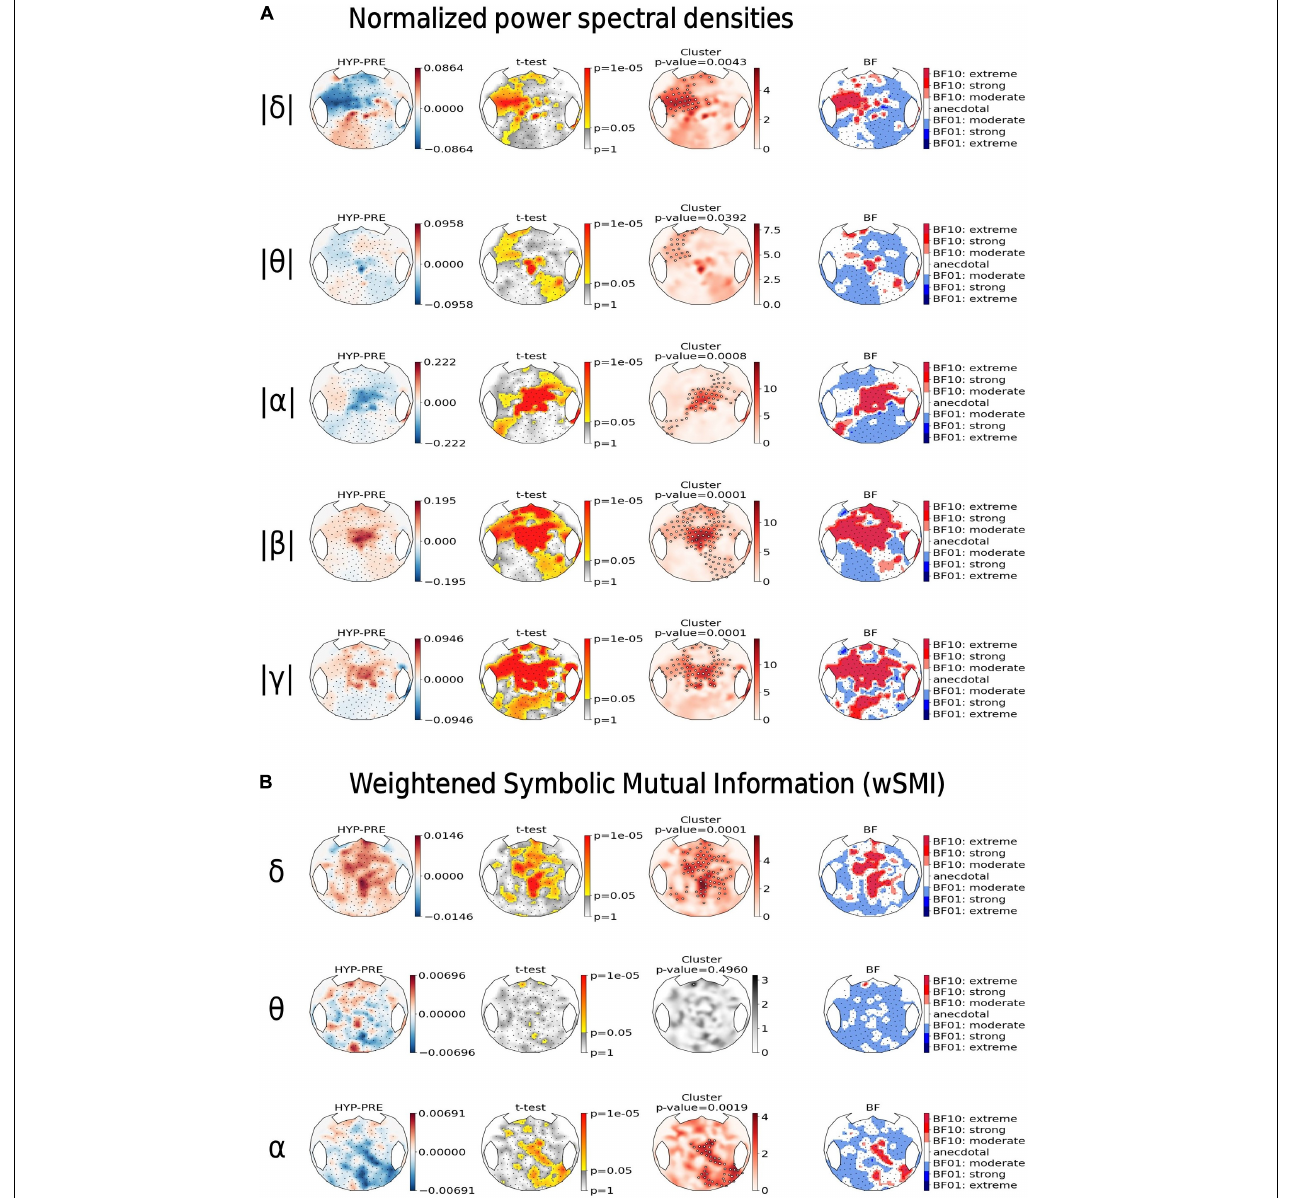
FIGURE 5 | Hypnotic deafness was associated with an increase in high-frequencies power and band-specific modulation of functional connectivity. Topographical maps of the normalized power spectral densities (PSD) (A) and the connectivity marker weighted symbolic mutual information (wSMI) (B) , computed at different frequency bands [delta ( δ ), theta ( θ ), alpha ( α ), beta ( β ), and gamma ( γ )]. For each state marker (row), from left to right: the first plot shows the contrast between baseline (PRE) and hypnotic deafness (HYP) states (HYP minus PRE), at each sensor; the second plot shows the result (uncorrected p -value in a logarithmic scale) of the independent t -test (HYP vs. PRE), at each sensor; the third plot shows the results of a cluster-based permutation test for control of multiple comparisons (red: significant cluster; gray: non-significant cluster); and the fourth plot shows the Bayes Factor (logarithmic scale) of the corresponding t -test (BF10: in favor of the existence of a difference between the two conditions; BF01: in favor of the null-hypothesis). Compared to baseline condition, hypnotic deafness was associated with a decrease in low-frequencies power over a left-anterior cluster, an increase in high-frequencies power over a centro-anterior cluster and band specific changes in functional connectivity (increase in delta band, decrease in alpha band, and absence of significant modification in the theta